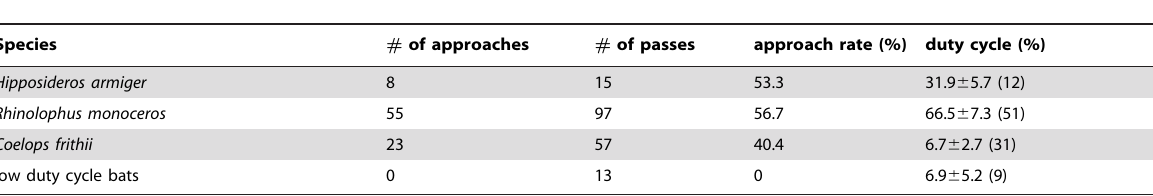
Table 1. Number of bat passes and approaches recorded around the fluttering target.